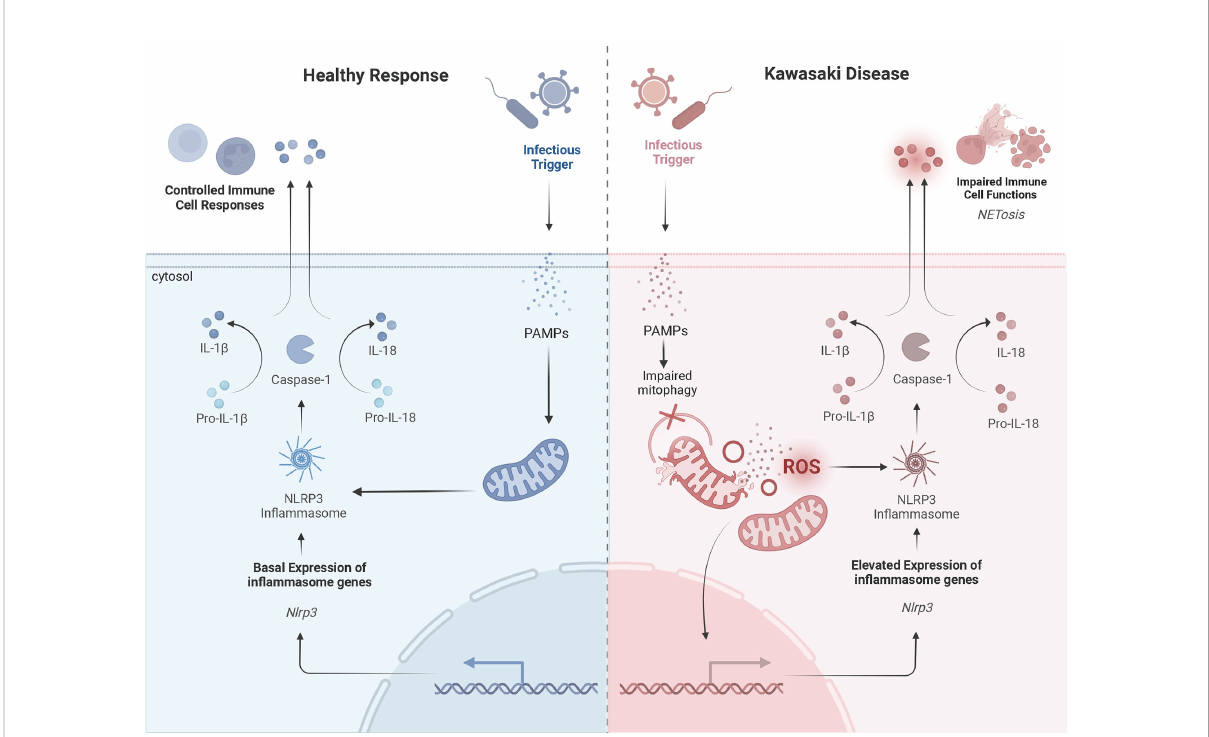
FIGURE 2 A Prospective Comparison of a Healthy In fl ammatory Response and that in Kawasaki DiseaseProspective mechanisms of mitochondrial dysfunction and exaggerated activation of NLRP3 in fl ammasomes in KD upon infection compared to a healthy response. The healthy response is in blue, on the left-hand side of the fi gure. The KD response is in red, on the right-hand side of the diagram. Formation of the NLRP3 in fl ammasome complex occurs in the cytosol of monocytes/macrophages in the presence of PAMPs and/or DAMPs (i.e., cytosolic mROS and mtDNA). A healthy in fl ammatory response upon infection involves appropriate signaling from the mitochondria and activation of the NLRP3 in fl ammasome to clear the infection. In KD, damaged mitochondria release more mROS and mtDNA into the cytosol, which exaggerates activation of the NLRP3 in fl ammasome. This promotes NETosis and impairs immune cell functions. Adapted from “ Suppression of In fl ammasome by IRF4 and IRF8 is Critical for T Cell Priming ” , by www.BioRender.com (2022). Retrieved from https://app.biorender.com/biorender-templates